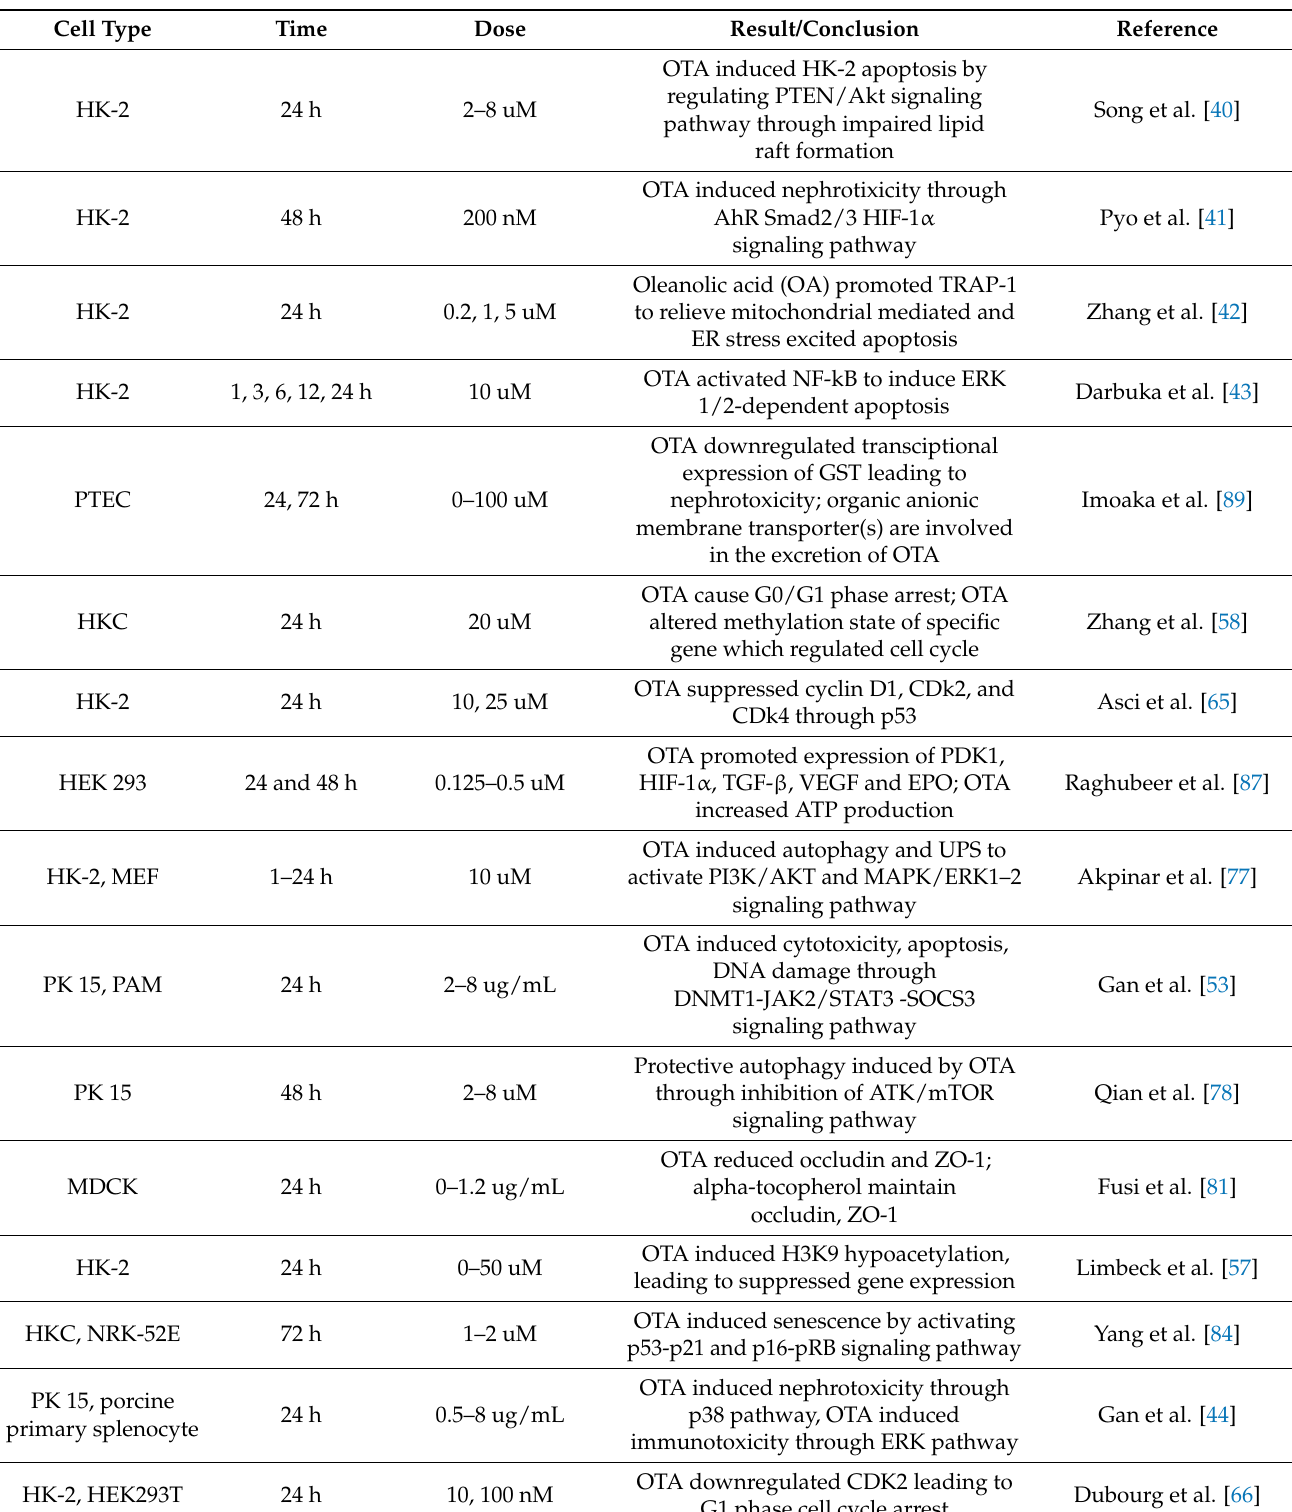
Table 1. In vitro OTA-induced nephrotoxicity